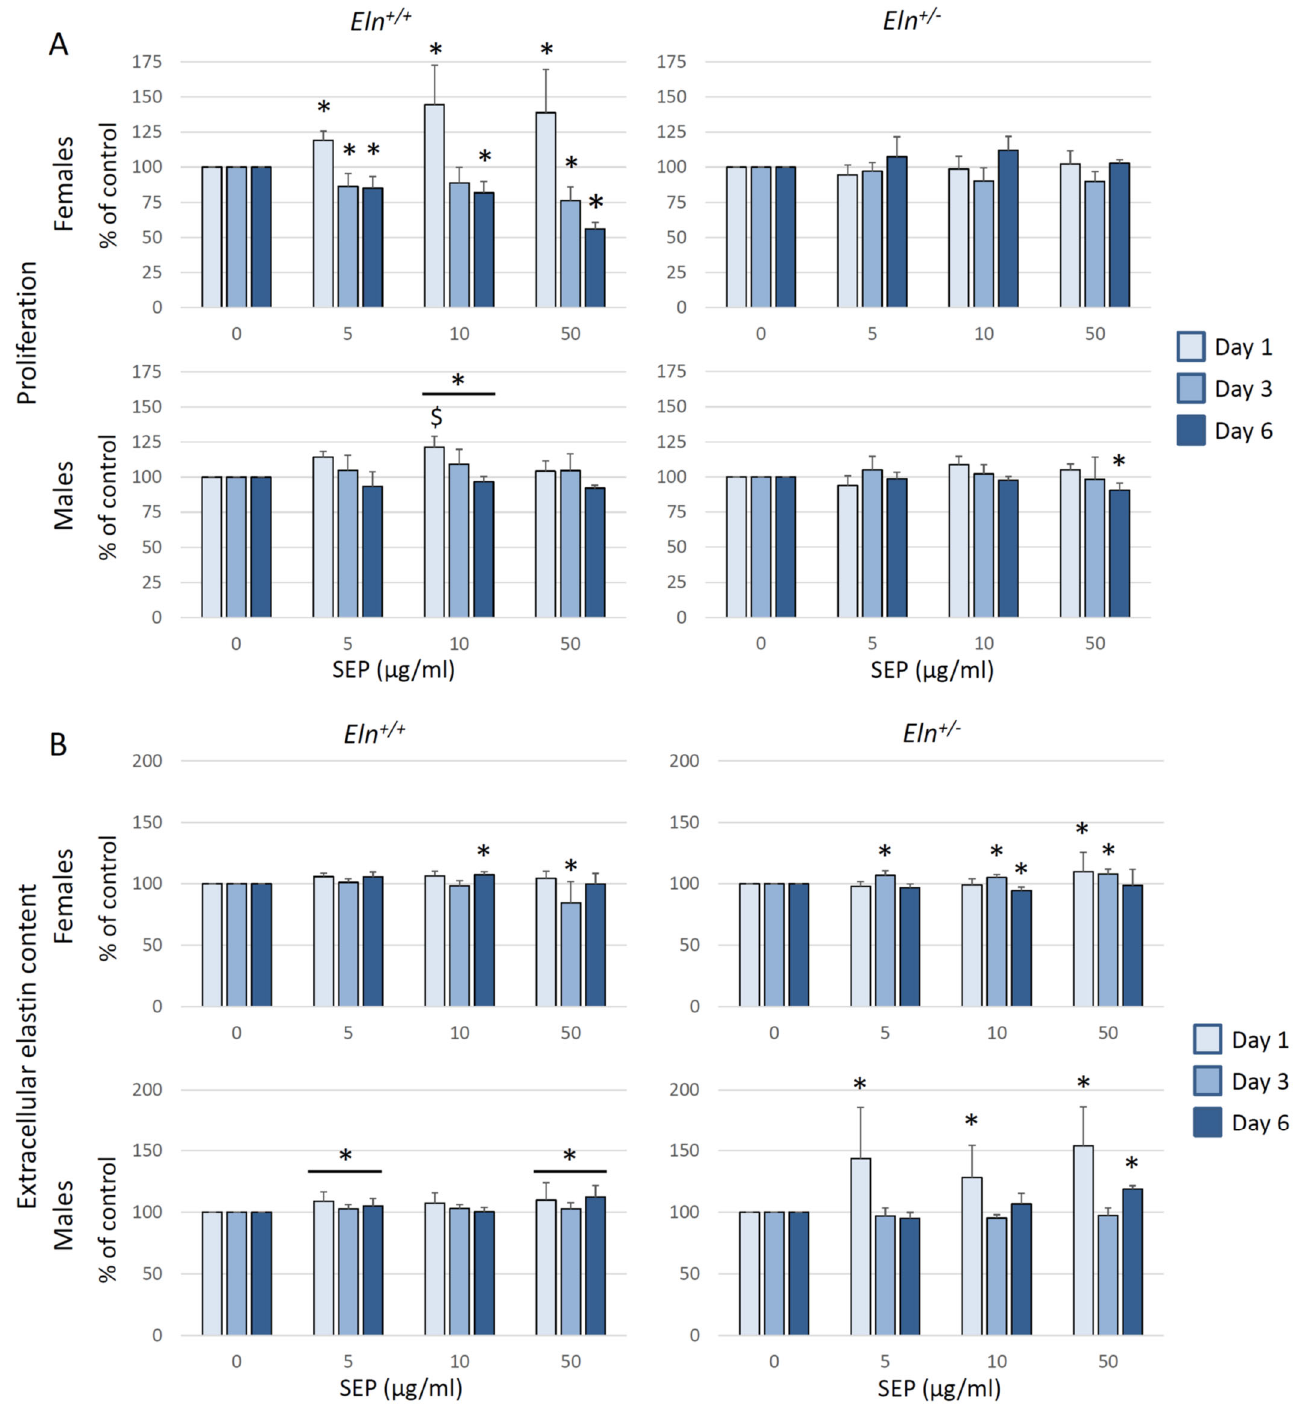
Figure 11. Proliferation and extracellular elastin content in primary cultures of aortic VSMCs from male or female Eln +/+ or Eln +/- mice. VSMCs were treated with SEP (0, 5, 10 or 50 µ g/mL) for 1, 3 or 6 days. ( A ) Impact of SEP treatment on VSMC proliferation, evaluated by using the MTT assay. The results are expressed as percent of the control value (0 µ g/mL SEP) of the same day. ( B ) Impact of SEP treatment on extracellular elastin content, evaluated by using an ELISA assay. The results are expressed as percent of the control value (0 mg/mL SEP) of the same day. * significant difference with same day control (three-way ANOVA, followed by LSD test for paired comparisons, p ≤ 0.05). $ significant difference at day 1 with same day control (two-way ANOVA, followed by LSD test for paired comparisons, p ≤ 0.05). Values are mean ± SEM. n = 3–5 primary cultures from separate animals in each group.